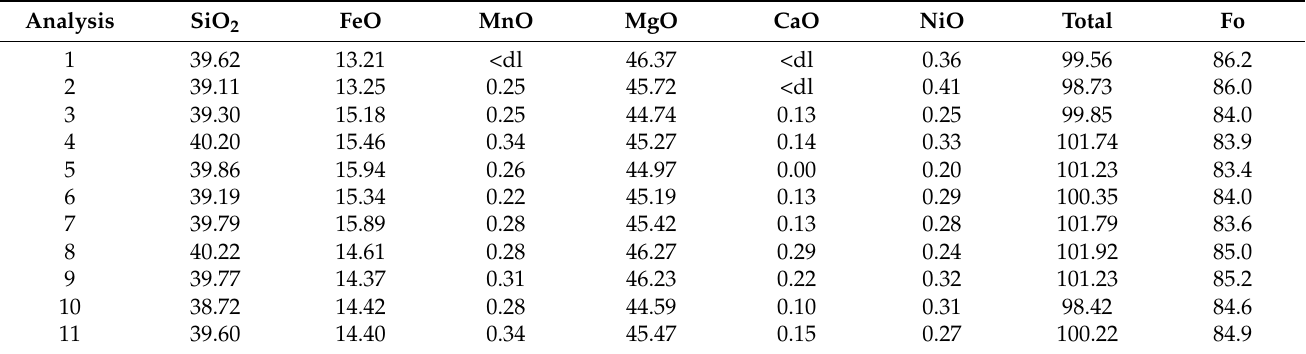
Table 4. Major element composition (by SEM-EDS) of olivine from of the Apshiyakhta intrusion phlogopite–olivine clinopyroxenite (Barangol Complex), Gorny